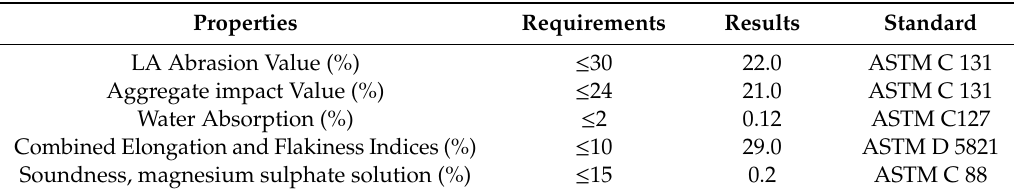
Table 1. Properties of the aggregates.